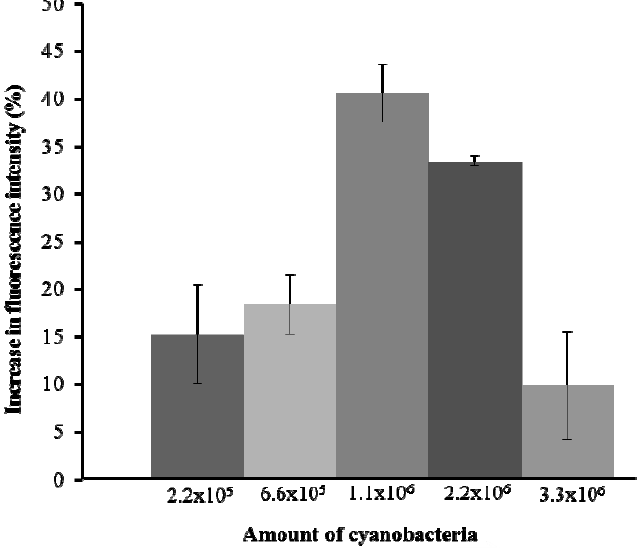
Figure 2. Fluorescence yields from different amounts of immobilized cyanobacteria.